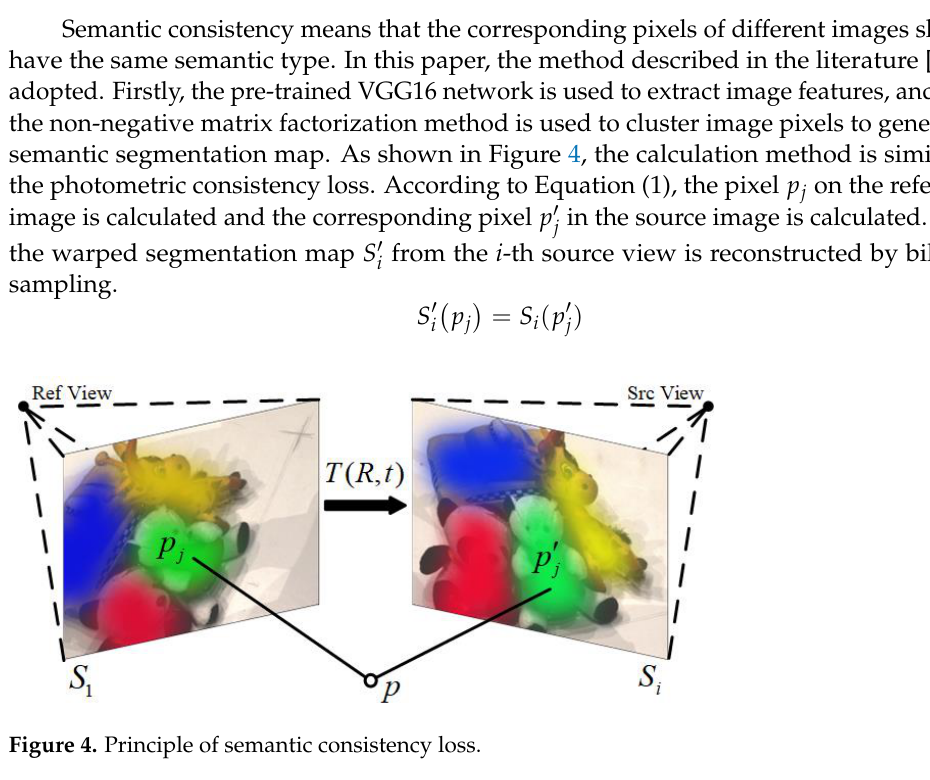
6 of 18 Figure 3. The photometric difference of different visual angles under the same illumination. Semantic consistency means that the corresponding pixels of different images should have the same semantic type. In this paper, the method described in the literature [20] is